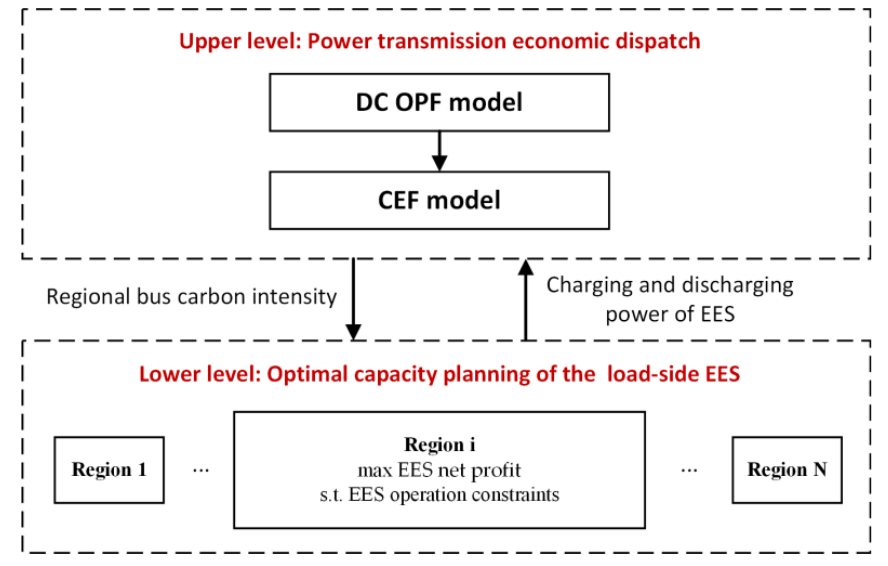
Figure 3. Structure of the bi-level model.